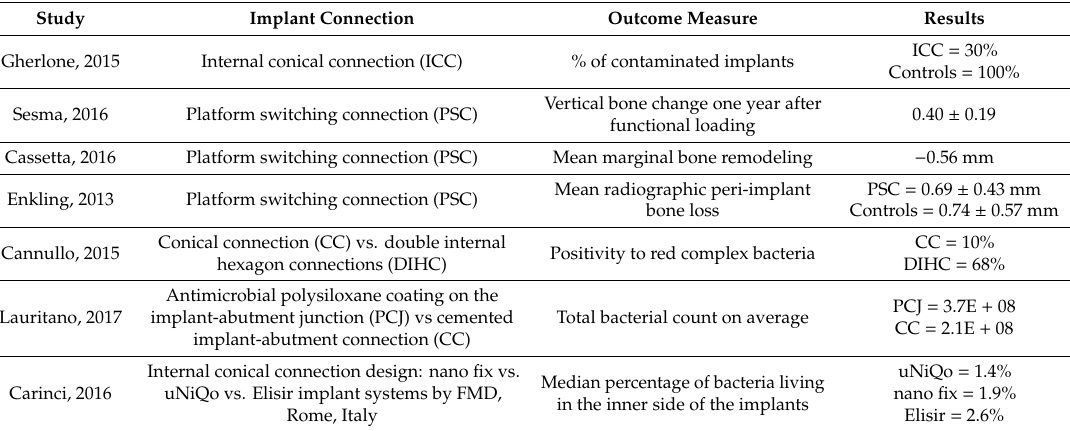
Table 4. Results of individual